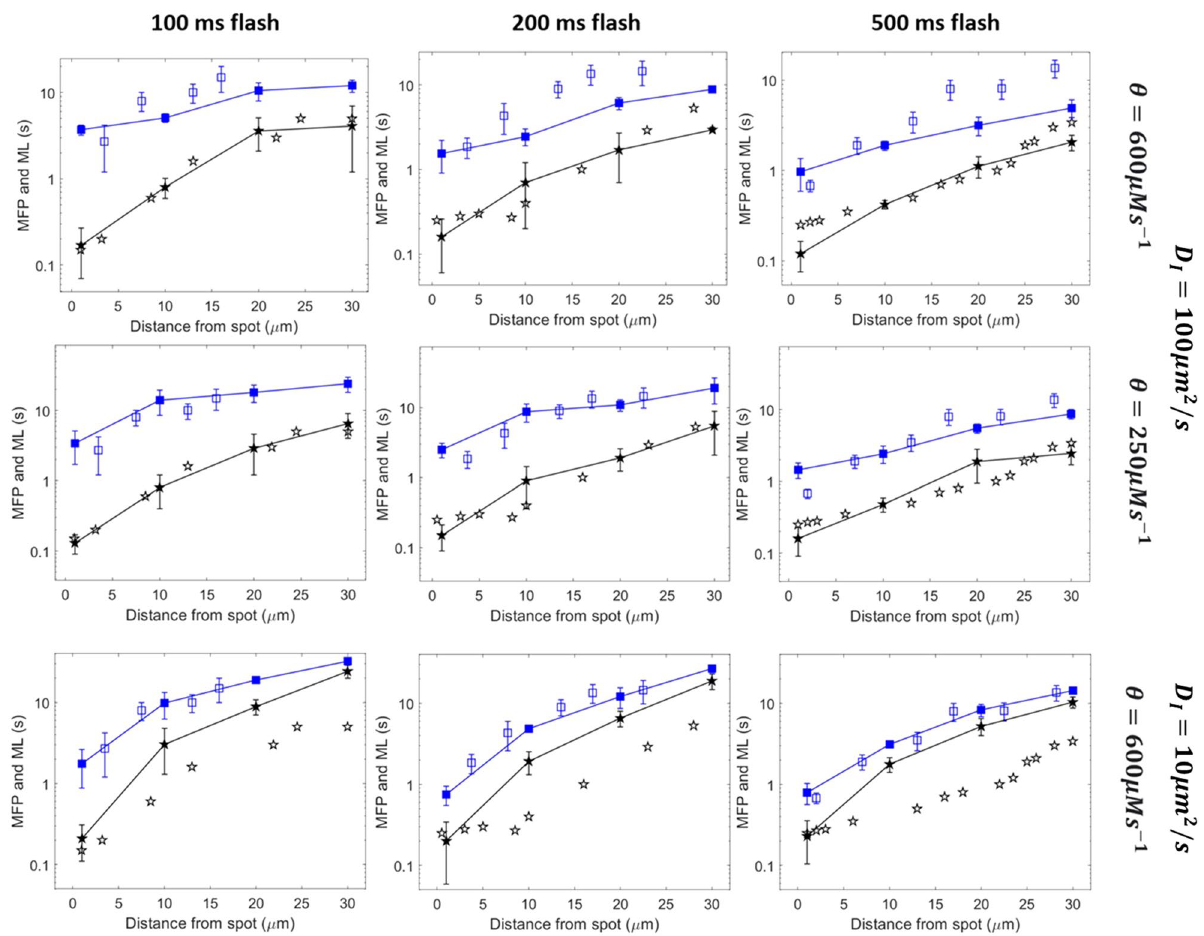
Figure 4. Mean latencies (ML) and minimal first puff latencies (MFP) as simulated with an effective IP 3 diffusion coefficient equal to 100 μm 2 s −1 (first and second rows) or 10 μm 2 s −1 (third row) and a rate of IP 3 increase at the photorelease spot of 600 μMs −1 (first and third rows) or 250 μMs −1 (second row). In all panels, squares represent mean latencies and stars, minimal first puff latencies. Plain symbols are theoretical predictions while empty symbols are the experimental observations of Dickinson et al. 11 , estimated from their figures. Lines are drawn between simulation results. Simulations are performed in a 2D ellipse-shaped geometry with the spot of IP 3 release occurring in a 0.25 μm radius circle at one extremity of the simulated cell. For each theoretical point, 50 independent simulations were run, considering one cluster at a time. Error bars indicate ± SEM. For minimal first puffs, the 50 simulations were divided in 10 groups of 5 simulations among which the minimal first puff was considered, except for the case θ = 250 μMs −1 and the 500 ms flash for which 100 simulations were run for the shortest